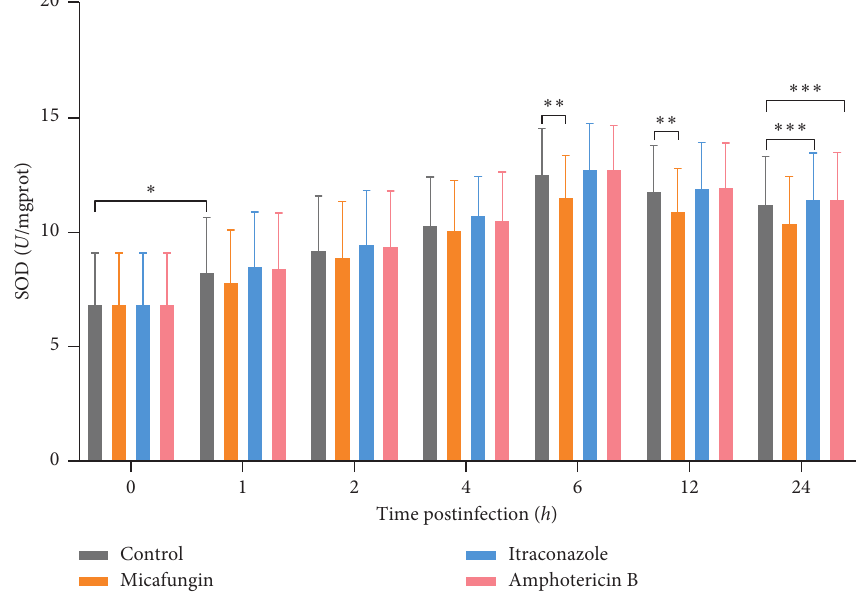
Figure 1: SOD activity of C. glabrata in macrophages pretreated with three antifungal drugs. We measured the SOD activity of macrophages treated with MCF, ICZ, and AmB. The control group was not pretreated with antifungal agents. The SOD level after 1 hour was significantly increased compared with the SOD level of nonphagocytized C. glabrata (0 hour) ( ∗ , P < 0 . 05). The mean SOD level of fungus-infected macrophages treated with MCF was lower than that of untreated fungus-infected macrophages, especially 6–12 hours after infection ( ∗∗ , P < 0 . 05). There was no significant difference in SOD levels between the untreated and ICZ- or AmB-treated fungus-infected macrophage groups ( ∗∗∗ , P > 0 .